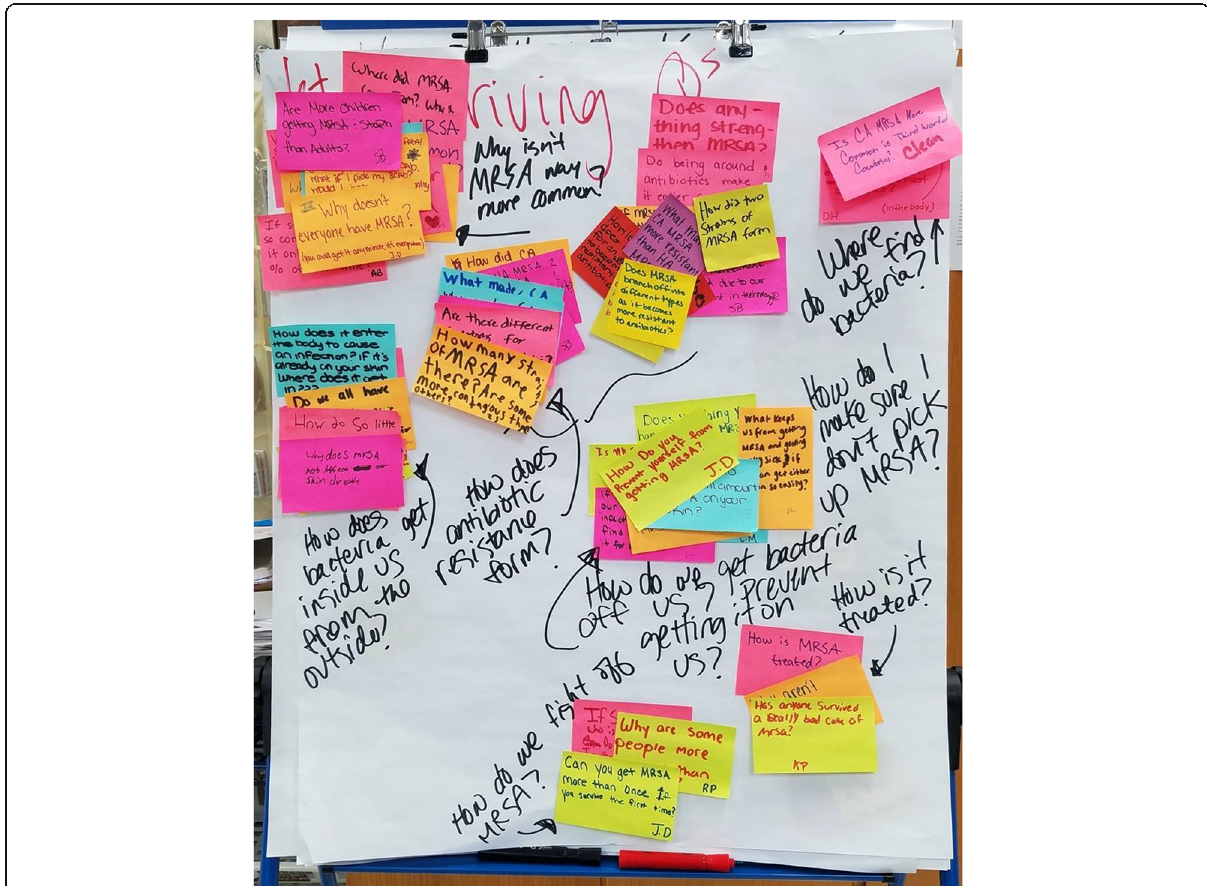
Fig. 2 A driving question board of questions from students from Ms. H ’ s classroom. Each individual sticky note is a student ’ s question. Students organized them into clusters as they shared them, and the teacher scribed a description for an emerging theme for a cluster as students identified them. Clusters for this class included “ How does bacteria get inside us from the outside, ” “ How do we get bacteria off us / prevent getting it on us, ” and “ How is it [MRSA] treated? ” Themes and example questions are shown in Table